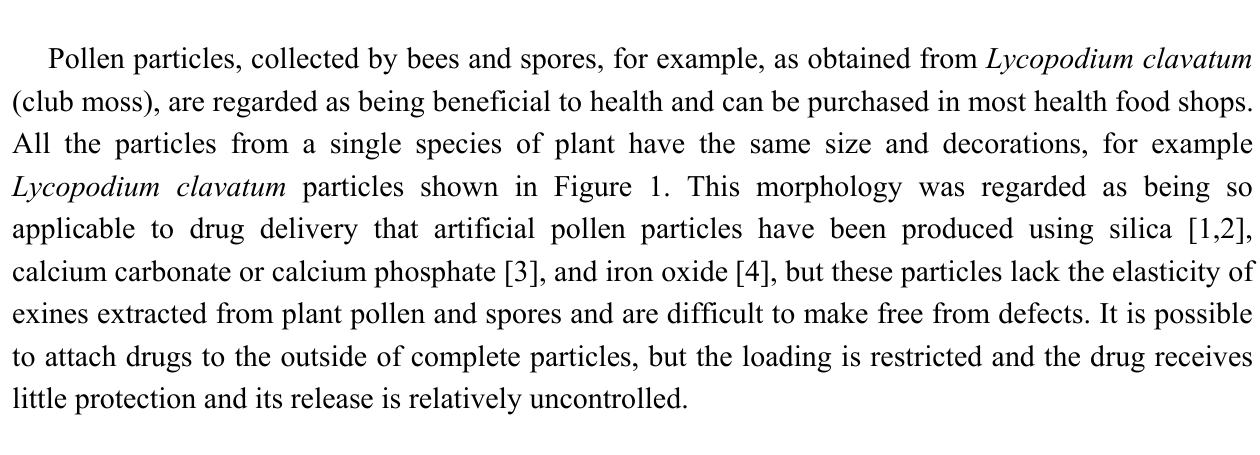
Figure 1. Scanning electron microscopy (SEM) picture of Lycopodium clavatum spores showing homogeneity of size and